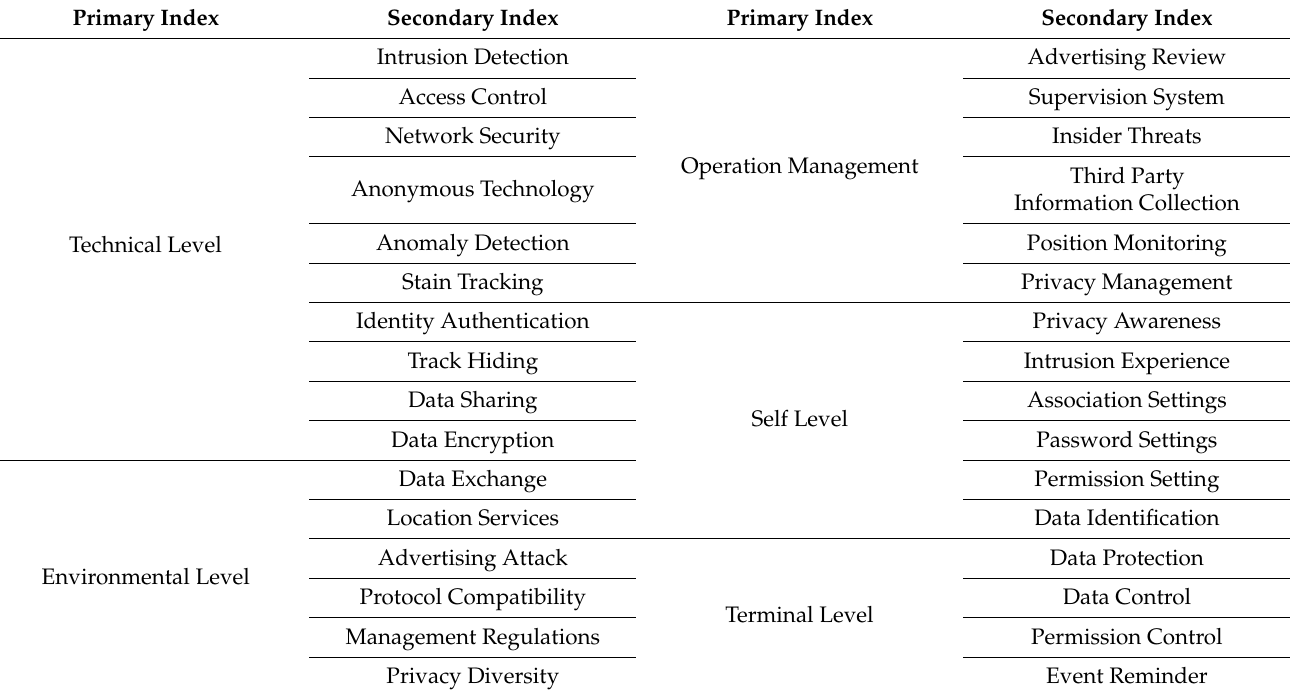
Table 4. The risk assessment index system of the data leakage of intelligent mobile